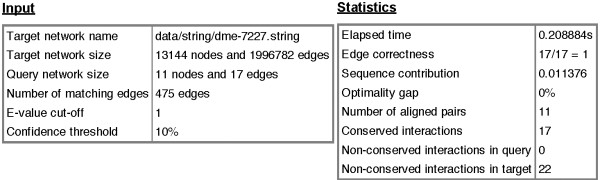
NATALIEQsummary statistics for run number 5 (Emax = 1). Alignment of the Wnt query network against the target PPI network (STRING) of D. melanogaster using the topology score function.